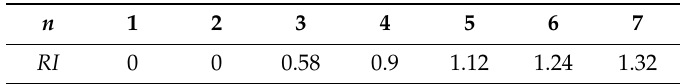
Table 3. Random inconsistency indices for different values of ( n ) [24,25].